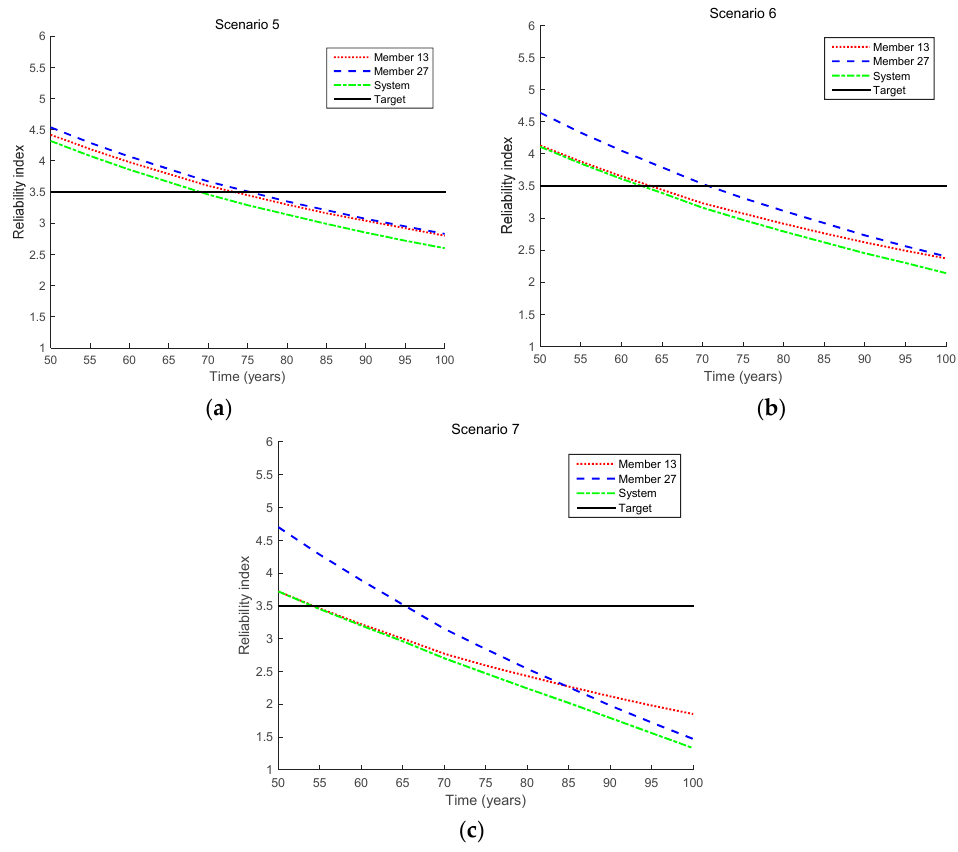
Figure 9. Reliability updating results by the proposed method for inequality cases (Scenarios 5–7 in Table 3). ( a ) Scenario 5; ( b ) Scenario 6; ( c ) Scenario 7.